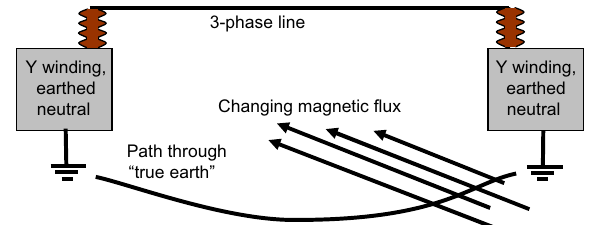
Fig. 3. Induction of GICs in the power